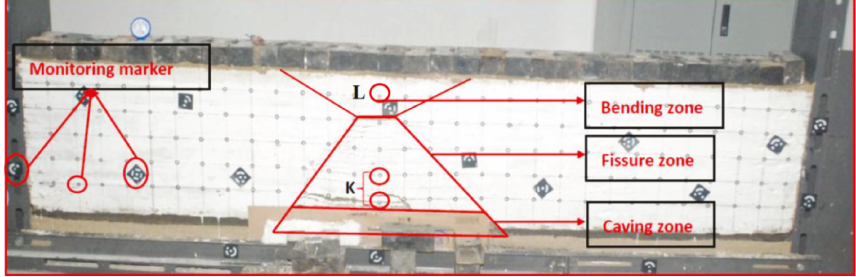
Figure 7: Overburden failure characteristics in model excavation by caving